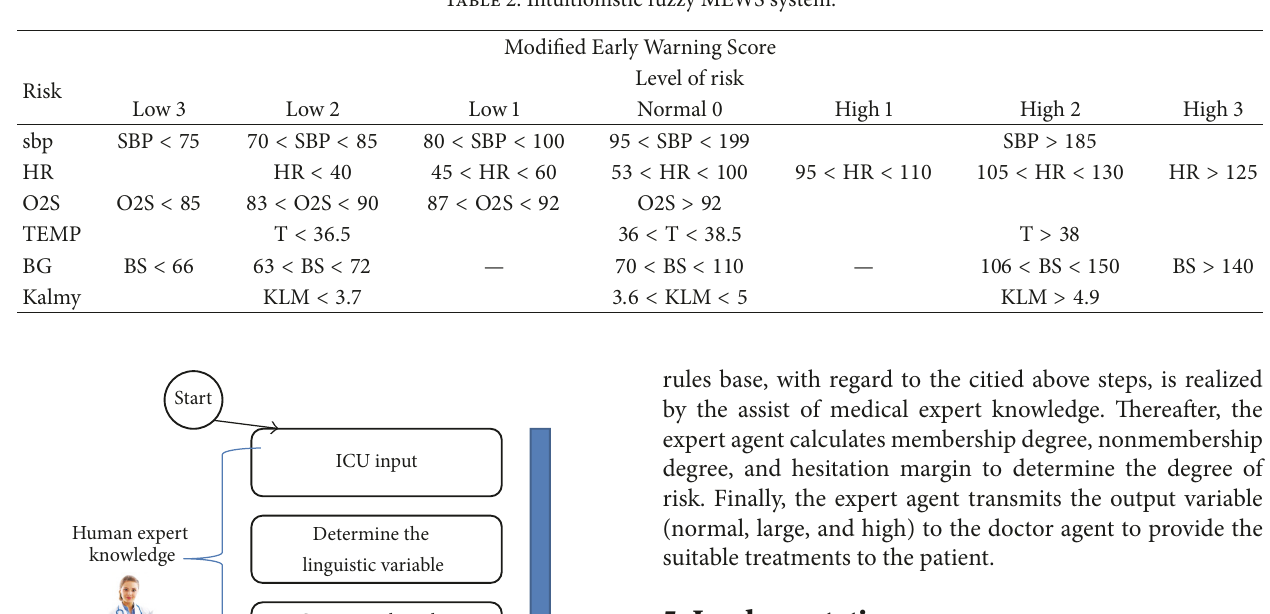
Table 2: Intuitionistic fuzzy MEWS system.